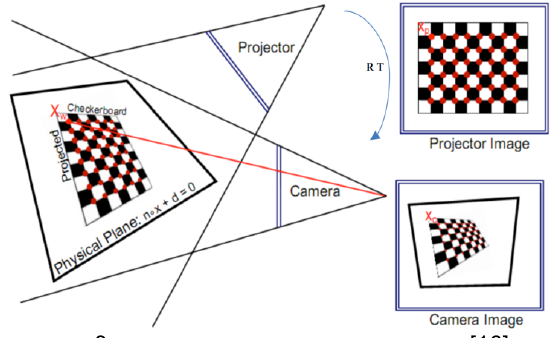
Figure 3 - Representation of a Projector-Camera system